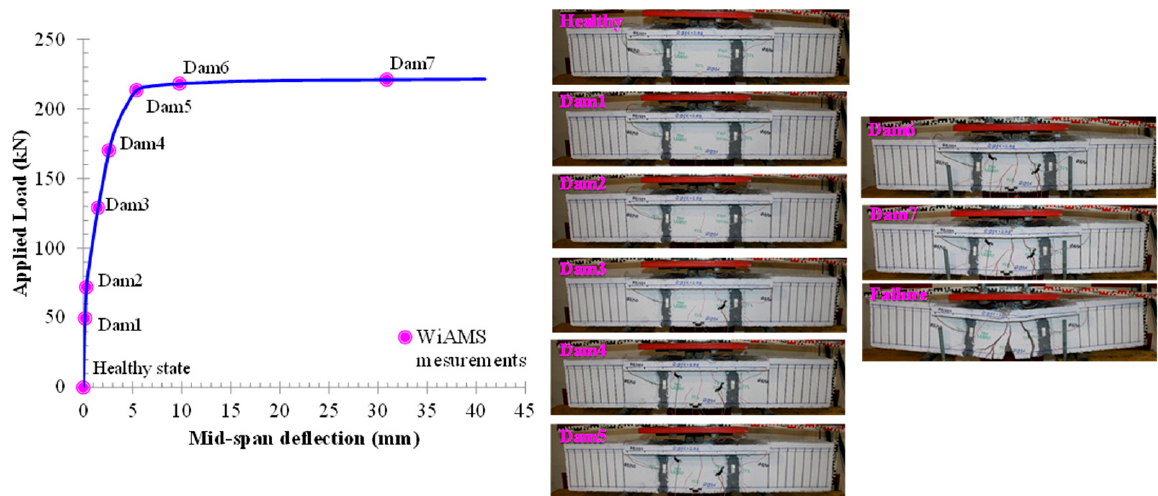
Figure 7. Cracking pattern and experimental behavior of specimen T-FRP.